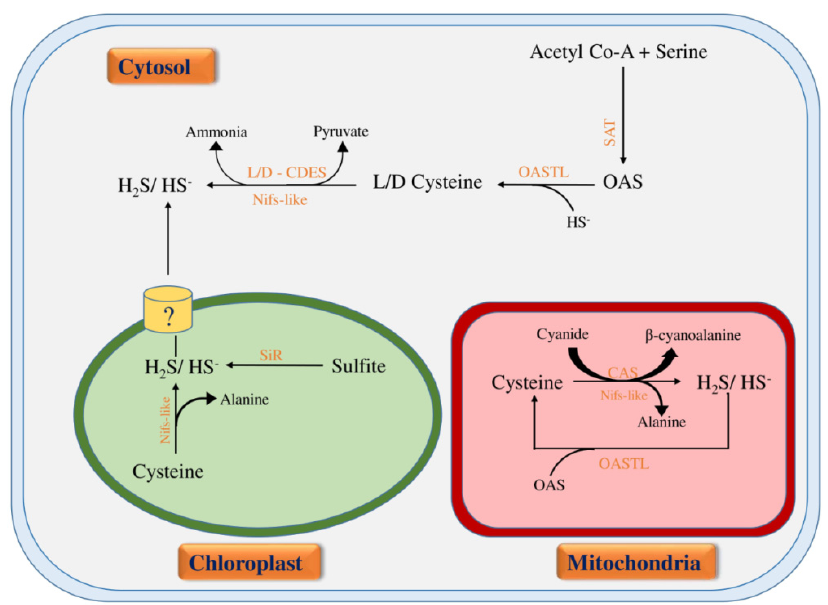
Figure 2. Biosynthesis of H 2 S in plants: In plants, biosynthesis of H 2 S occurs in cytosol, chloroplast, and mitochondria. In the cytosol, L/D cysteine is formed by the addition of sulfide into OAS (O-acetyl-ser) catalyzed by OASTL (O-acetylserine(thiol)lyase) enzyme. H 2 S is released from L/D cysteine in a reaction catalyzed by L/D-CDES (L/D cysteine desulfhydrases) along with the release of ammonia and pyruvate. In chloroplast, H 2 S is formed from sulfite by SiR (sulfite reductase) during photosynthetic sulfate reduction pathway. It is transported to cytosol from chloroplast by an unknown transporter. In mitochondria, H 2 S is formed from cysteine by the concomitant release of cyanide and β -cyanoalanine catalyzed by CAS ( β -cyanoalanine synthase). Nifs-like proteins also release H 2 S by converting cysteine to